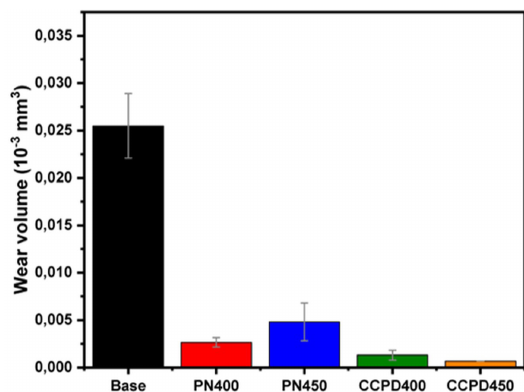
Figure 6. Volume of wear of the samples submitted to the sphere- disk type tribological